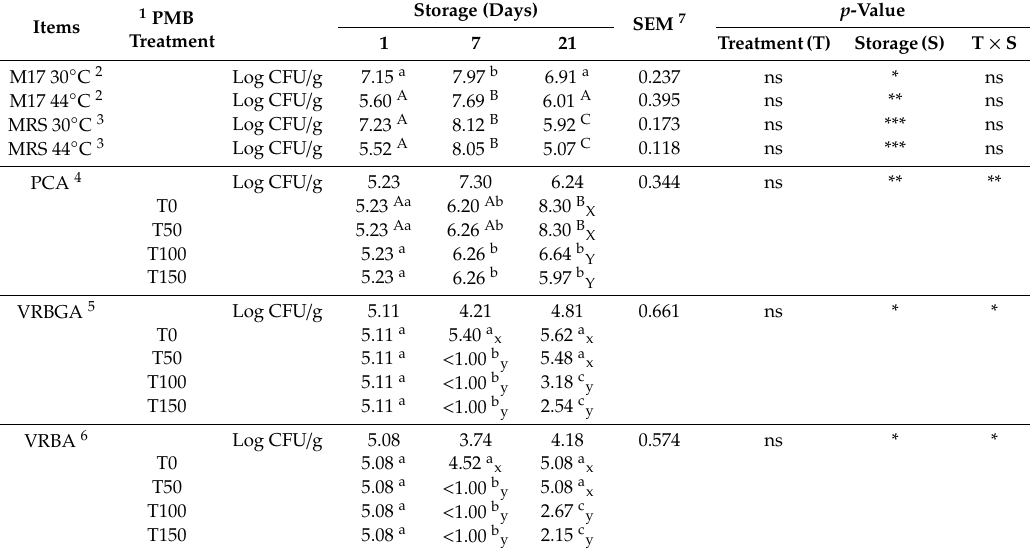
Table 3. Microbiological evolution of prickly pear by-product (PPB) during storage and in relation to treatments with potassium metabisulfite (PMB) (Least Square